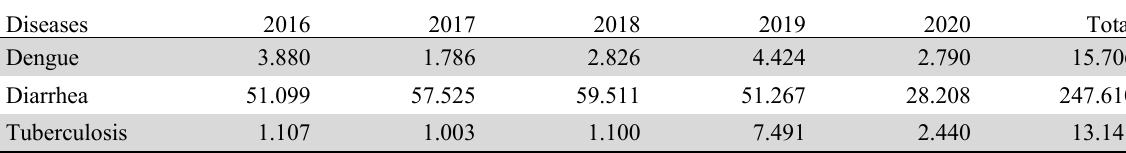
Registered number of the cases of dengue, diarrhea, TB